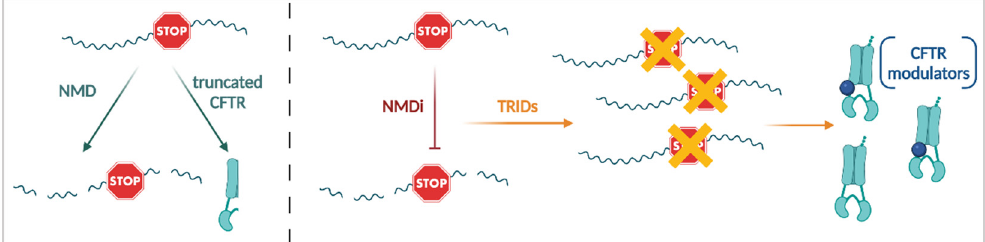
Figure 7. CFTR with premature termination codon (PTC) mutations: defects and therapeutic strate- gies. Left: PTC CFTR mutations present two specific defects: the mRNA is often degraded via nonsense mediated mRNA decay (NMD), and the resulting protein is truncated. Right: To overcome these challenges, NMD inhibitors (NMDi) and Translational Readthrough Inducing Drugs (TRIDs) are investigated. As TRID treatment does not necessarily result in incorporation of the native amino-acid, these treatments can further be complemented with CFTR modulators.